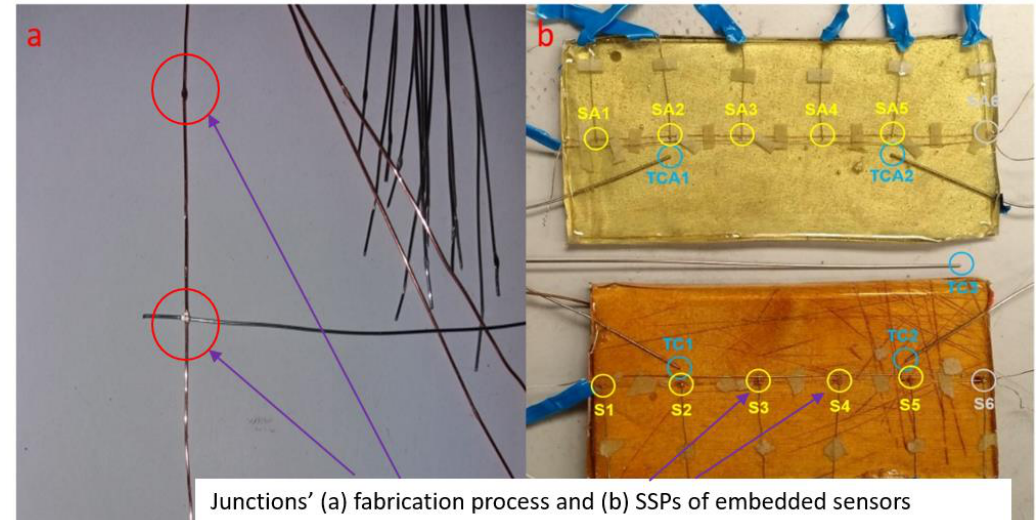
Figure 2. ( a ) Wire just before soldering process, ( b ) aluminium (top) and wood (bottom): mounted sensors following embedding in epoxy resin, showing the location of sensor sensing points and thermocouples. The wire seen running parallel to the copper line is a constantan wire which was not electrically connected to the multi-channel thermocouple array (MCTCA) during the experiment. SA6 and S6 developed a fault and were excluded from the results.